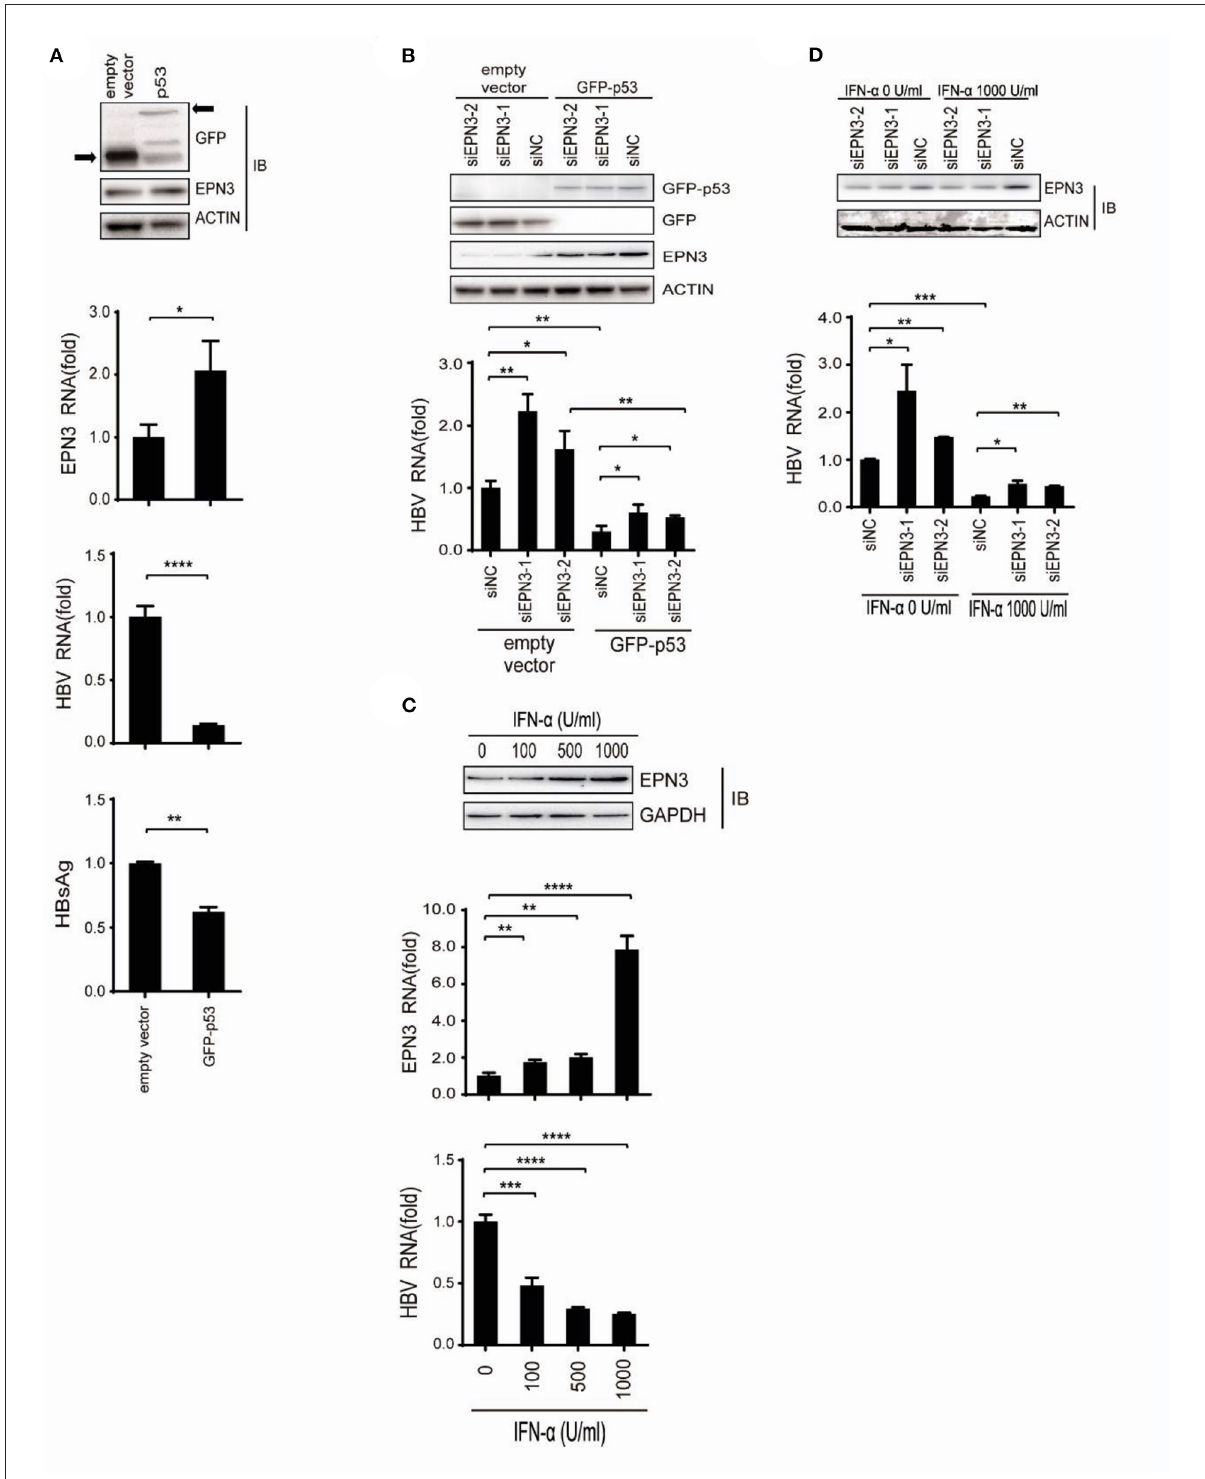
FIGURE6 EPN3 suppresses HBV replication downstream of IFN- α and p53. (A) Huh7 cells were transfected with pPB and the p53 expression vector. Three days after transfection, cells were harvested and subjected to western blot (top) and RT-qPCR analysis (middle), and the culture supernatant was to ELISA (bottom). The level of the empty vector transfectant is defined as value 1. (B) Cells were transfected with pPB, the p53 expression vector, and siEPN3. Three days after transfection, cells were harvested for western blot (top) and RT-qPCR analysis (bottom). The level of siNC